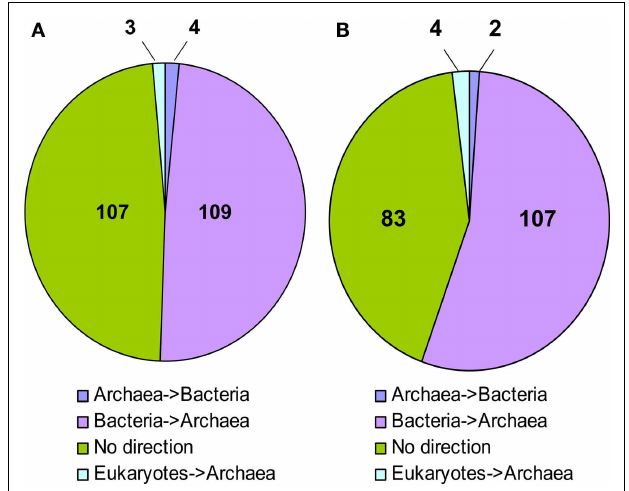
FIGURE 1 | Inferred direction of transfer of LGT candidates in M. stadtmanae according to (A) Neighbor-joining analysis and (B)